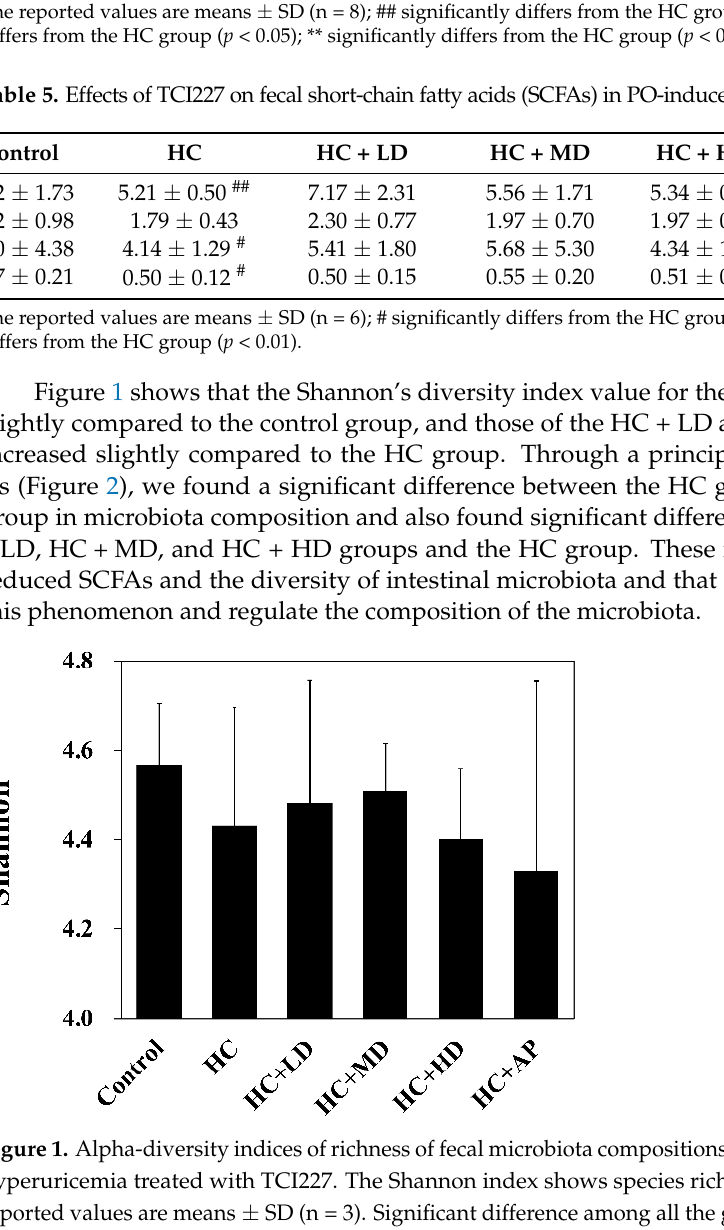
Figure 2. Effect of TCI227 on principal coordinates analysis (PCoA) index levels of fecal microbiota in rats with PO − induced hyperuricemia based on unweighted Jensen − Shannon distance measures of all samples based on OTU − level relative abundance profiles. Results are means for n = 3; # mean values are significantly different from control group ( p < 0.05); * mean values are significantly dif- ferent from HC group ( p < 0.05) (Jensen − Shannon, genus, exclude unclassified OTU (reads)). 3.4. TCI227 Changed Composition of Intestinal Microbiota Next, we wanted to explore whether TCI227 could change the composition of intes- tinal microbiota using 16S microbiota ribosomal DNA sequencing. The eight most abun- dant fecal microbiota phylum of the CTL, HC, HC + LD, HC + MD, HC + HD, and HC + AP groups are shown (Figure 3). The most abundant microbiota (phylum) were Firmicutes and Bacteroridetes. When the ratio of Firmicutes/Bacteroidetes or the number of